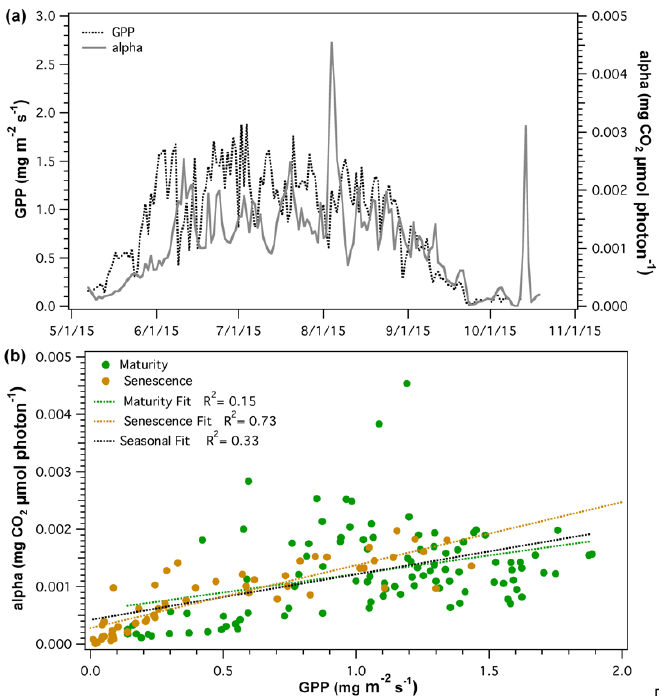
Figure 6. ( a ) Time series and ( b ) regression analysis of gross primary productivity (GPP) and apparent canopy quantum yield (alpha). Correlation between GPP and alpha was analyzed for the whole season (black), maturity (green), and leaf senescence (brown).